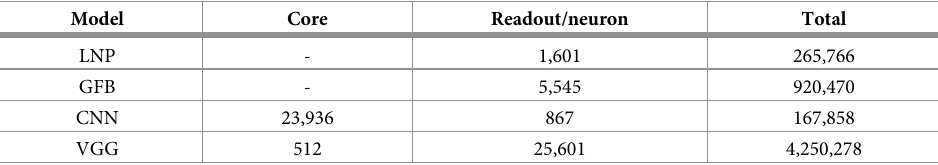
Table 2. Number of learned parameters for the different models. ‘Core’ refers to the part shared among all neurons. ‘Readout’ refers to the parameters required for each